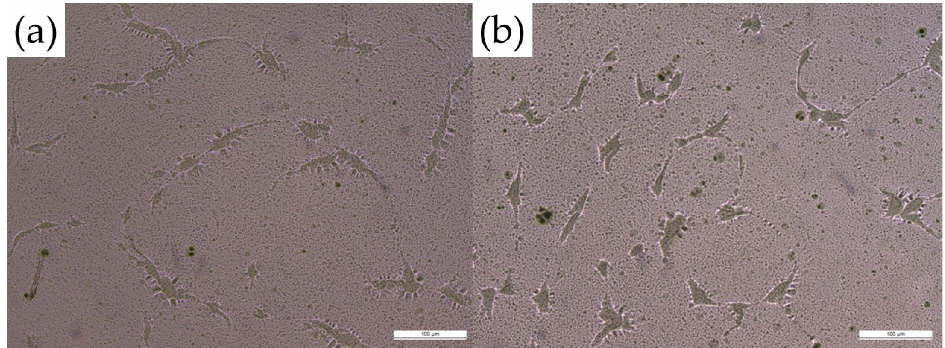
Figure 1. Microscopic images of the 20% PLGA formulation (F1) on glass sides ( a ) without and ( b ) with added drug (10× magnification) did not show drug crystallization after complete evaporation of the solvent.